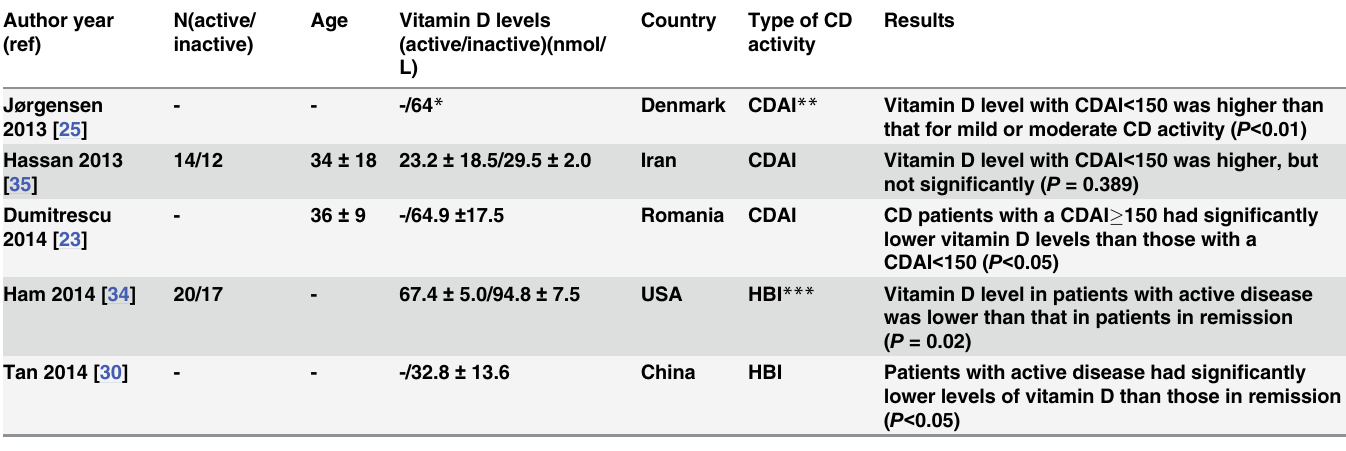
Table 3. Data for continuous variable group on vitamin D and CD